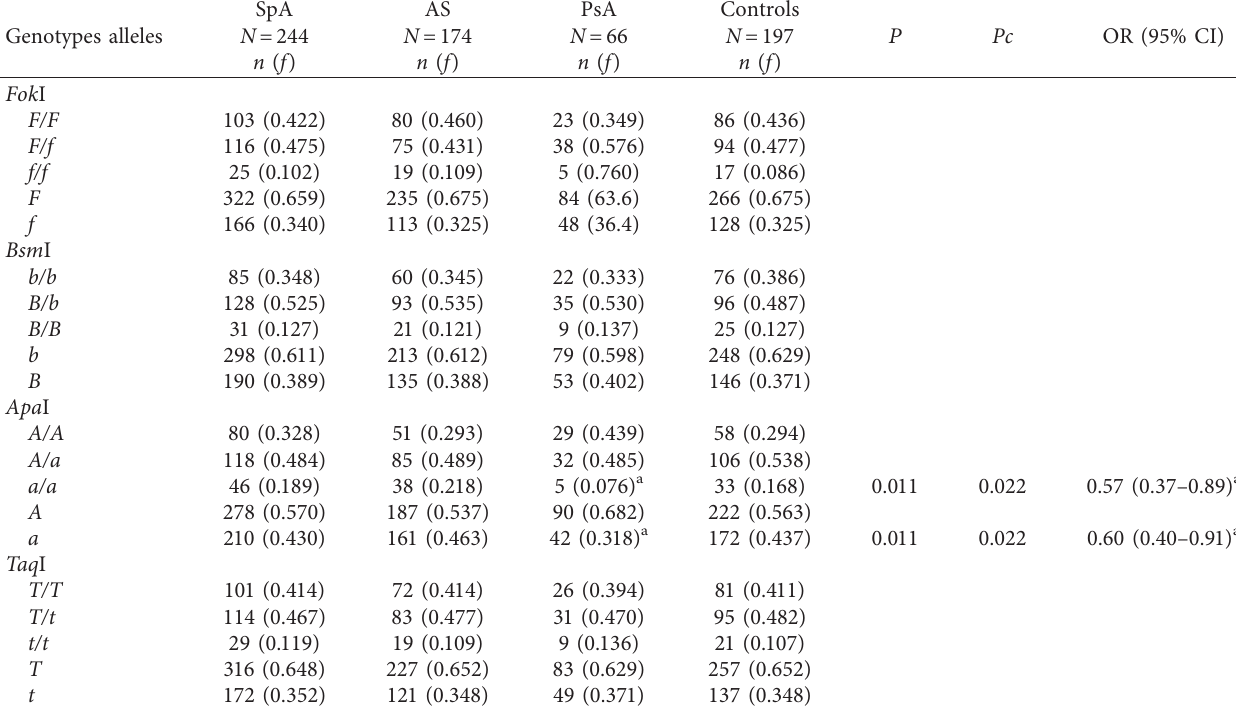
Table 3: Genotype and allele frequency distributions of Fok I, Bsm I, Taq I, and Apa I in patients with spondyloarthritis (SpA), ankylosing spondylitis (AS), and psoriatic arthritis (PsA) and controls.